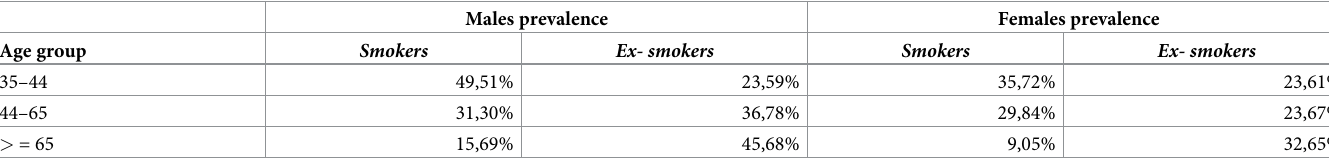
Table 2. Smoking prevalence by age range, sex and smoking status (National Health Survey